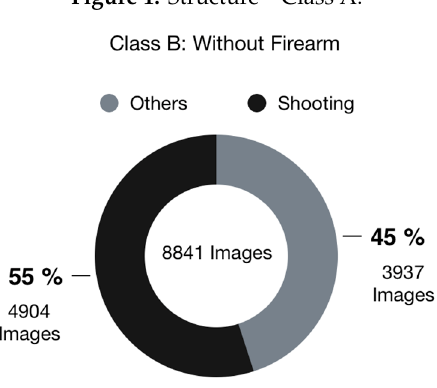
Figure 1. Structure—Class A.